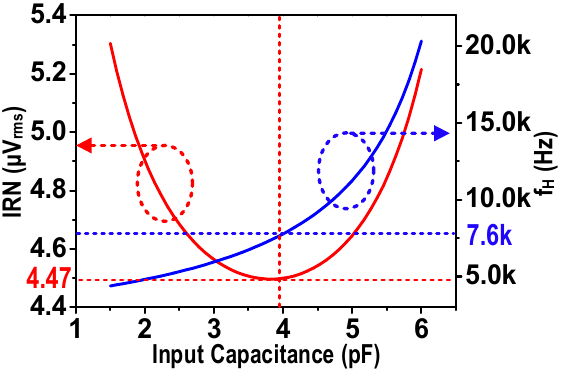
Figure 6. IRN and f H from an AC-coupled single-ended input and output LNA simulation based on OTA in Figure 2b with α = 0.7 and B =